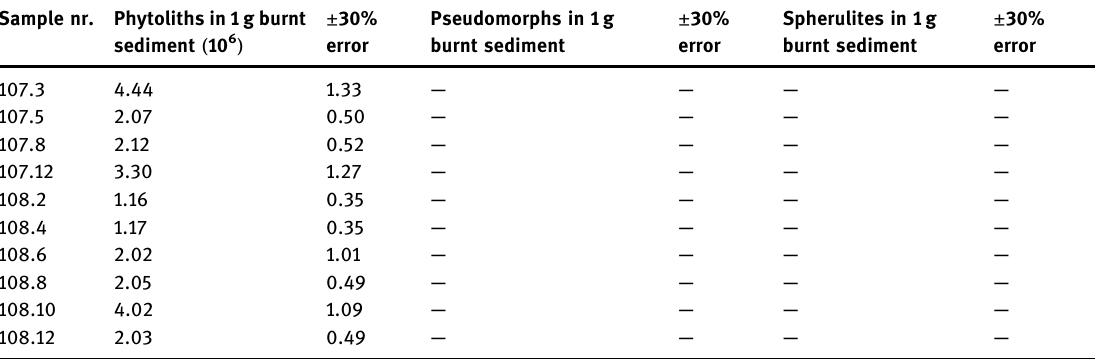
Table 1: Results of the micro - remains analysis Sample nr. Phytoliths in 1 g